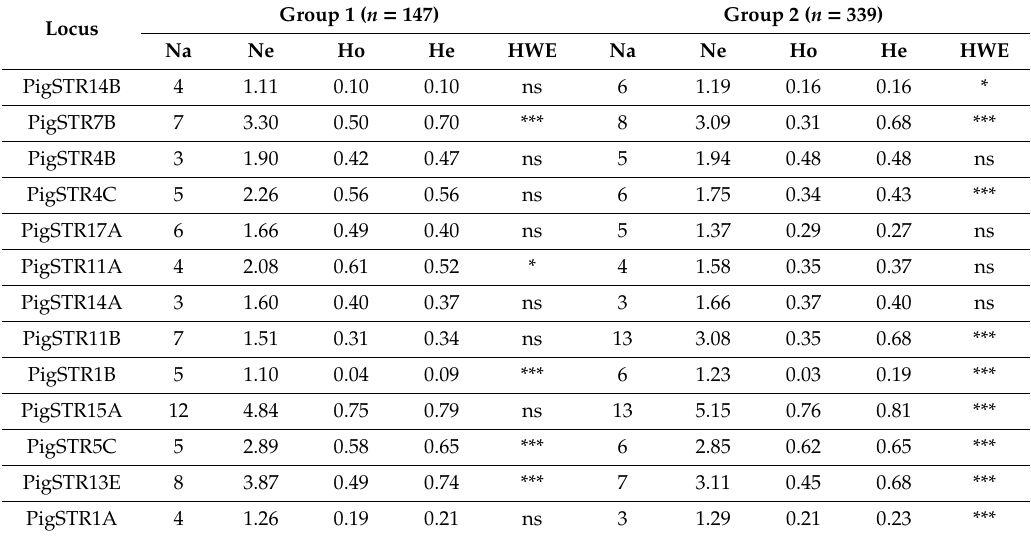
Table 2. Genetic diversity of Hungarian wild boars according to the clustering results.